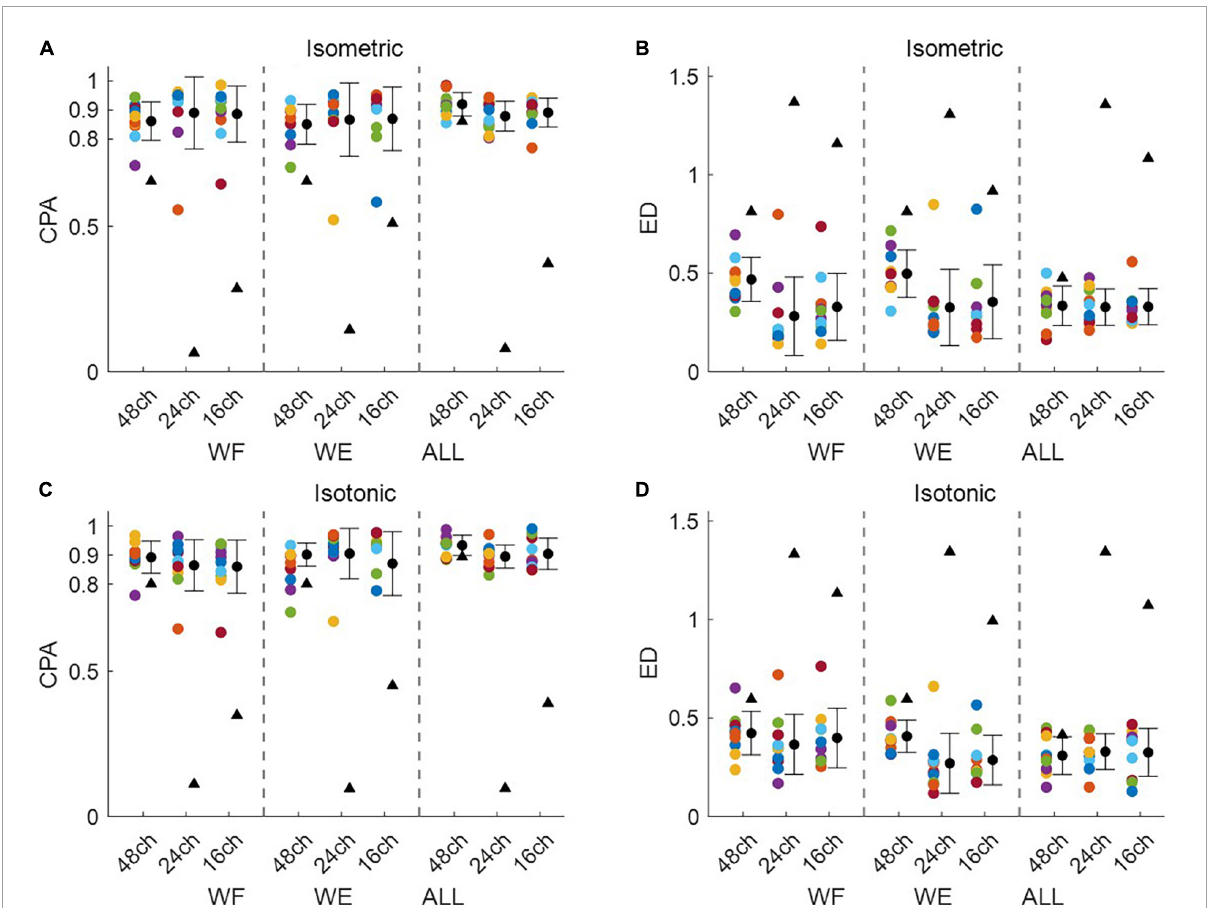
FIGURE3 Intra-mode similarity of muscle synergies for wrist movements. Both (A,B) isometric mode and (C,D) isotonic mode were included, (A,C) CPA and (B,D) ED were used as the similarity metrics. Three different electrode configurations denoted as 48ch, 24ch, and 16ch were considered, respectively. Herein, circles with different colors are corresponding to different subjects, the black triangles denote CPA thresholds and ED thresholds under each